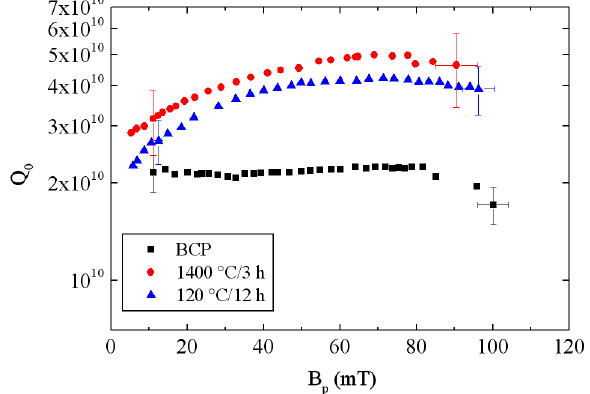
ð 2 : 0 K Þ vs B FIG. 7. Q p measured after etching by BCP, 0 followed by HT at 1400 (cid:1) C and by LTB. A Q ð 5 (cid:3) 1 Þ (cid:2) 10 10 was obtained at 90 mT.